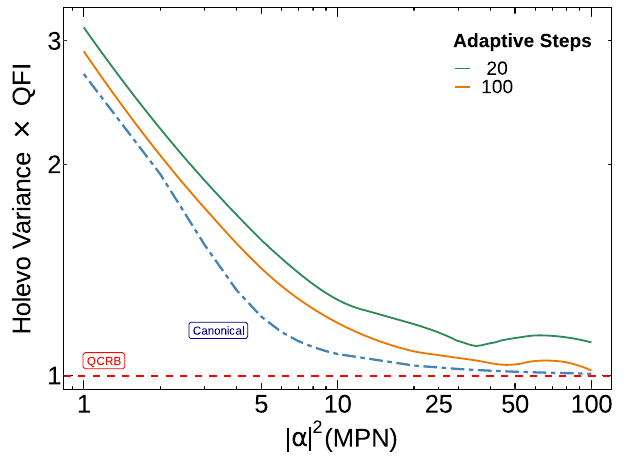
Fig. 3 Estimator variance produced by the non-Gaussian strategy. Holevo variance of adaptive Non-Gaussian strategies as a function of ∣ α ∣ 2 , normalized to QCRB, for different adaptive measurement steps (solid lines), together with the canonical phase measurement (blue dashed line). For L = 100 the Holevo variance differs from the QCRB by 3% exemplifying the tendency to the ultimate precision limit in the regime of large number of photons in the asymptotic limit. Simulations consist of 10000 Monte Carlo simulation sequences with PNR m =